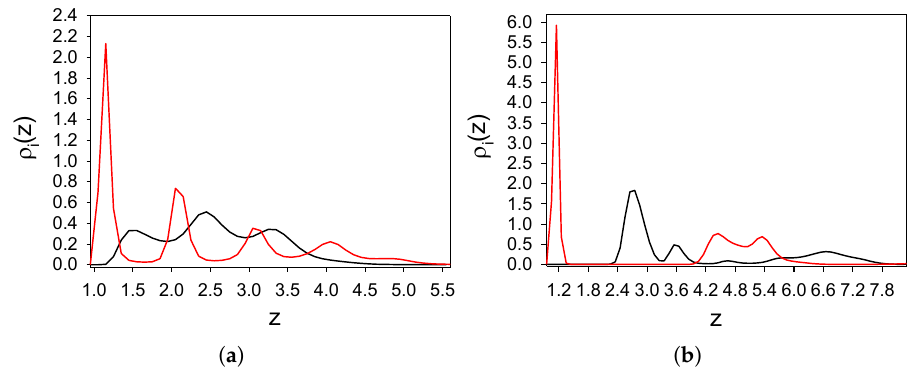
Figure 2. Distribution of the particles near a surface attracting the first and repulsing the second ρ 1 = 0.0012). Particle–particle component for ¯ T = 0.25 and ρ g = 0.0023 (volume fraction π 6 interactions are given by (1) and (2) for like and different particles, and wall–particle interactions are given by (3) and (4) for the first and the second component, respectively. Dimensionless densities ρ 1 ( z ) (red line) and ρ 2 ( z ) (black line) of the first and the second component as functions of a distance z from the surface are shown for ( a ) γ attr = 4 and ( b ) γ attr = 6. In both panels γ rep = 16. ¯ T = kT / (cid:101) , and ρ g denotes the dimensionless gas density far from the adsorbing substrate. z is in units of the particle diameter a . Simulations were performed for the initial number of particles N 0 = 6050. Very similar results were obtained for N 0 = 24,200.